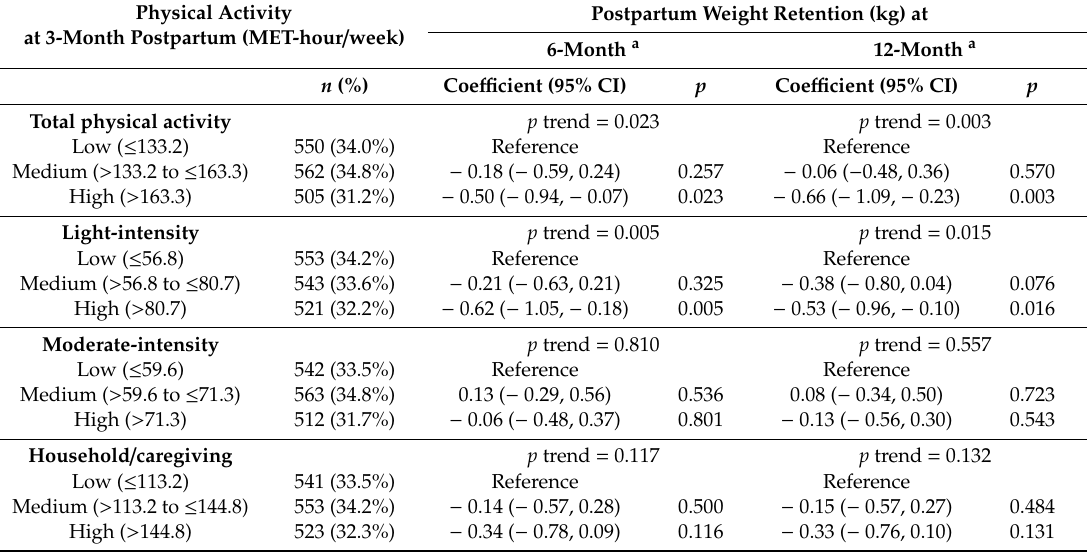
Table 3. Linear regression analyses of postpartum weight retention in relation to physical activity exposures ( n =